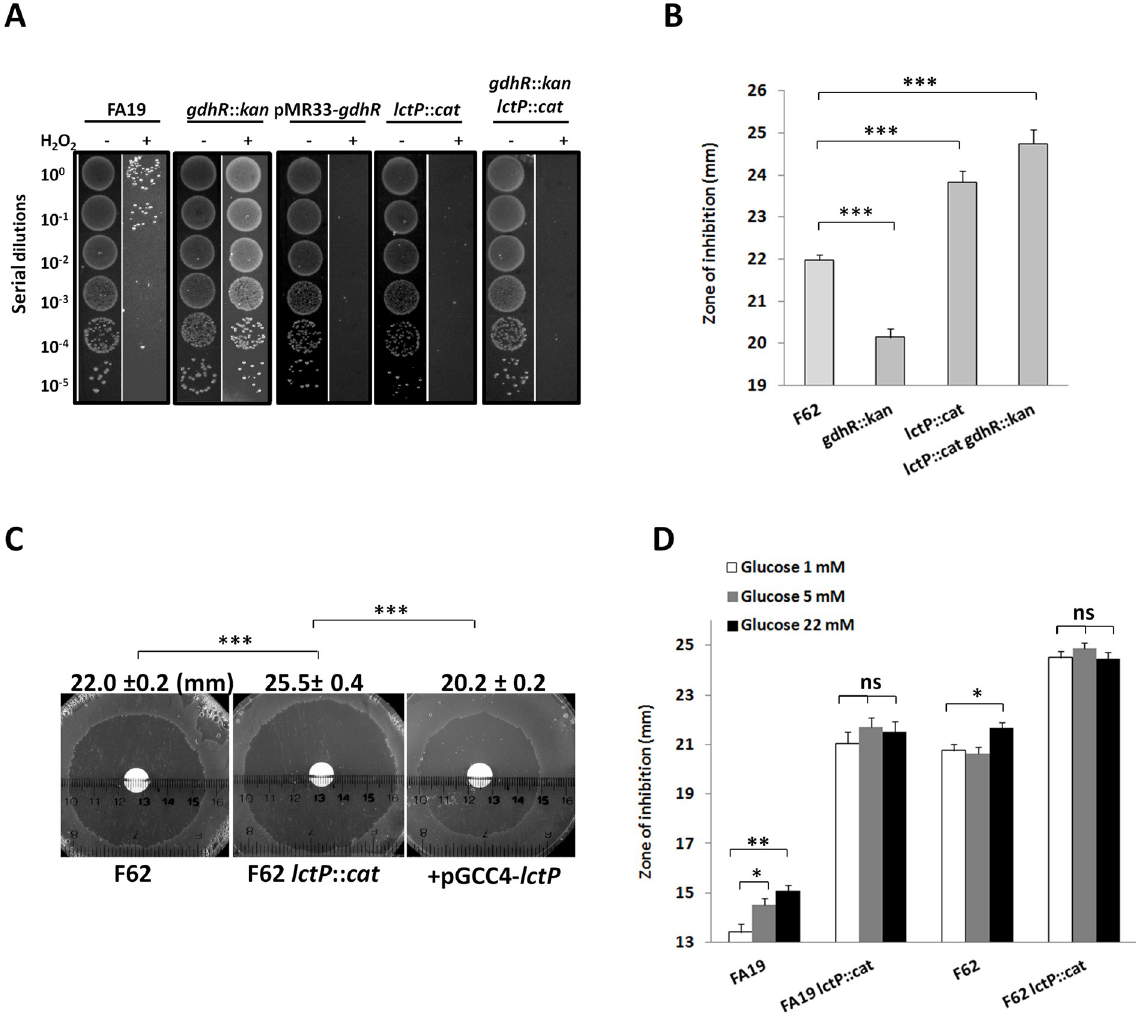
Fig 8. Regulation of lctP by GdhR and D-glucose impacts gonococcal resistance to hydrogen peroxide. A. Hydrogen peroxide susceptibility assay in GC-broth. 5 � 10 7 CFU/mL of strains FA19 and isogenic mutants gdhR :: kan , gdhR -complemented mutant JC02 (pMR33- gdhR ) in 1 mM IPTG, JC03 ( lctP :: cat ) and double mutant JC04 ( gdhR :: kan lctP :: cat ) were incubated overnight in 9 mM H 2 O 2 and cell viability was determined by serial dilutions and spot plating as described in Methods. B. The hydrogen peroxide susceptibility of WT strain F62 and its isogenic mutants JC16 ( gdhR :: kan ), JC05 ( lctP :: cat ) and JC24 ( gdhR :: kan lctP :: cat ) was determined in GC-agar plates using a H 2 O 2 disk diffusion assay. C. Genetic complementation of the lctP mutation.